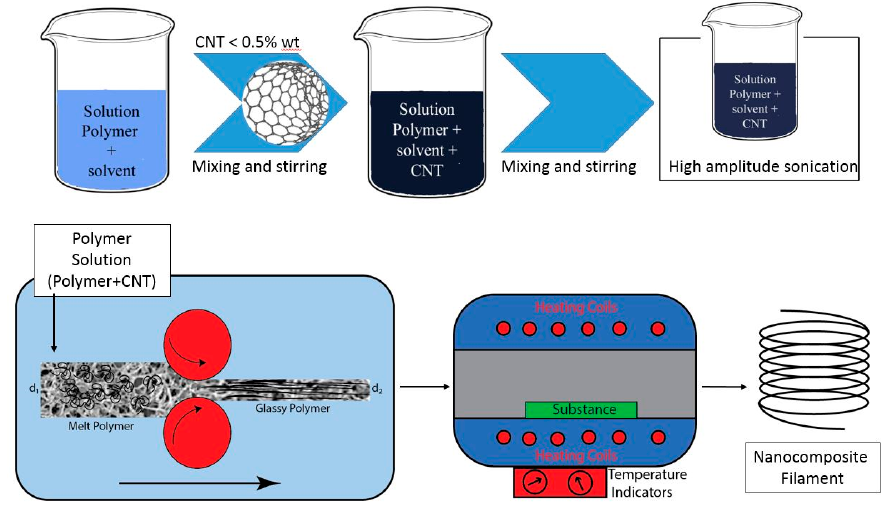
Figure 11. Schematic of suggested approach for filament